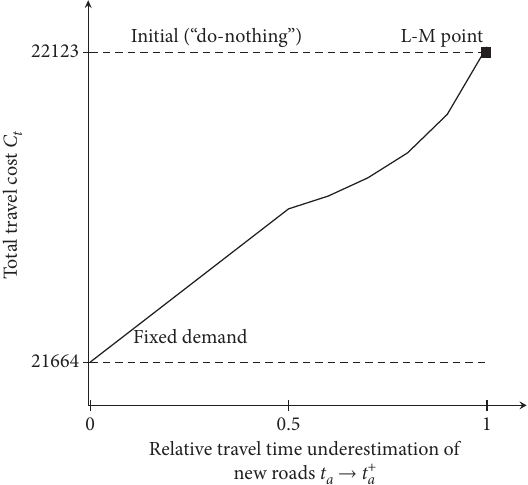
Figure 12: Travel costs C t against relative perceived cost decrease of the new road in the route-choice model.